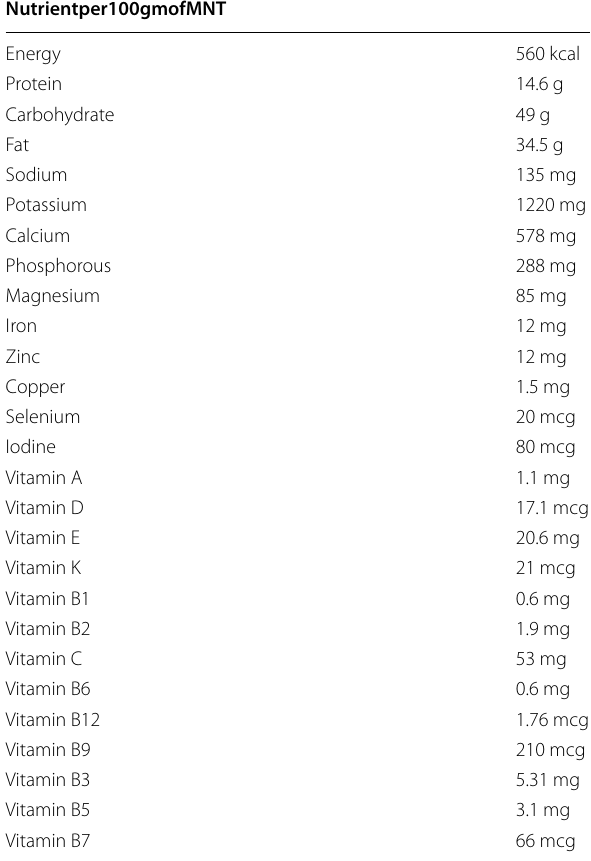
Table 2 Nutrient composition of Medical Nutrition Therapy (MNT) as per WHO recommendation (Jadhav et al. 2016)